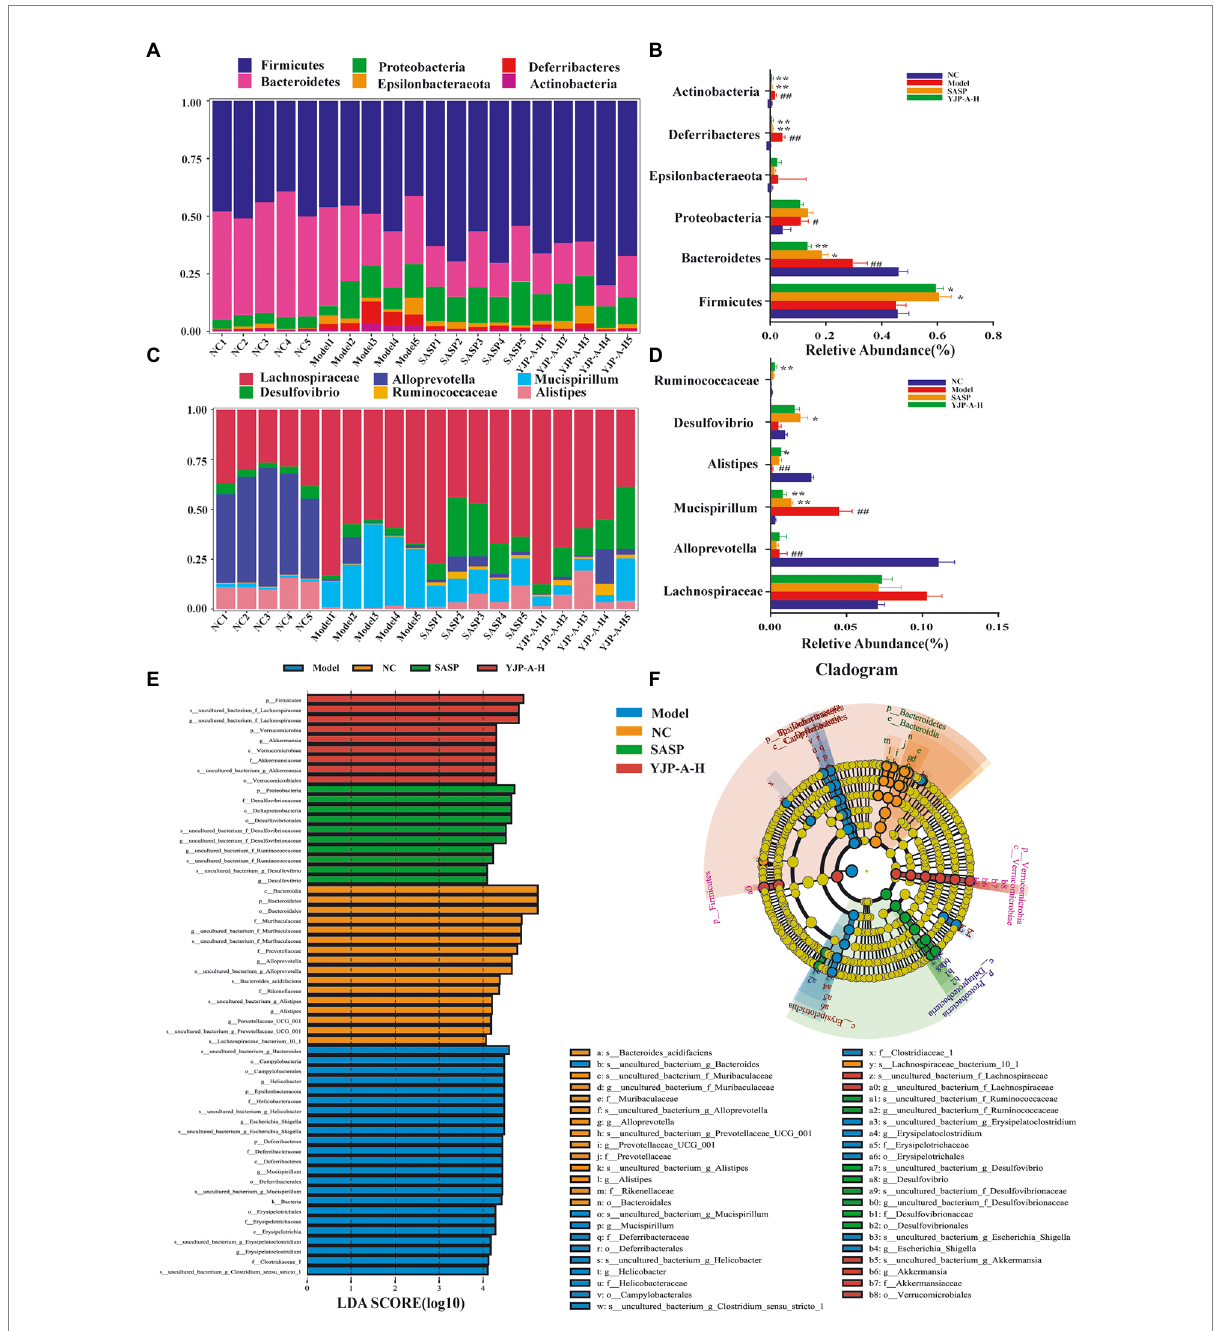
FIGURE 9 Effects of YJP-A-H on colonic mucosal flora structure in UC mice. Difference analysis at phylum (A,B) and genus (C,D) levels in mice of each group. (E) LDA score distribution histogram. LDA score > 4.0 indicates differentially abundant genera which was considered as biomarkers. (F) LEfSe cladogram. The root of the cladogram denotes the domain bacteria. Different colors indicate the different group hosting the greatest abundance. The size of each node represents their relative abundance. Data are expressed as the mean ± SEM, n = 5 per group. # p < 0.05, ## p < 0.01 vs. NC group; * p < 0.05, ** p < 0.01 vs. model